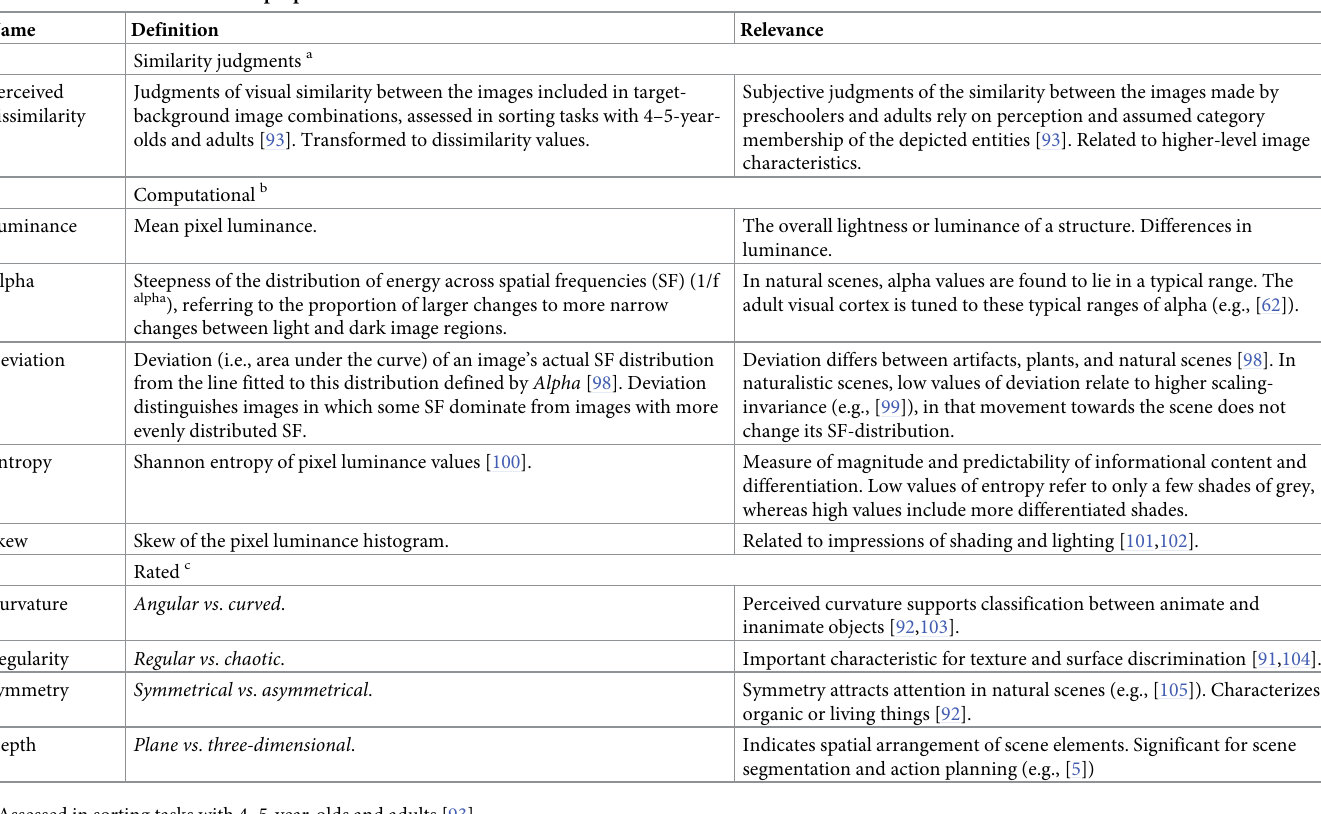
Table 1. Definitions of the visual